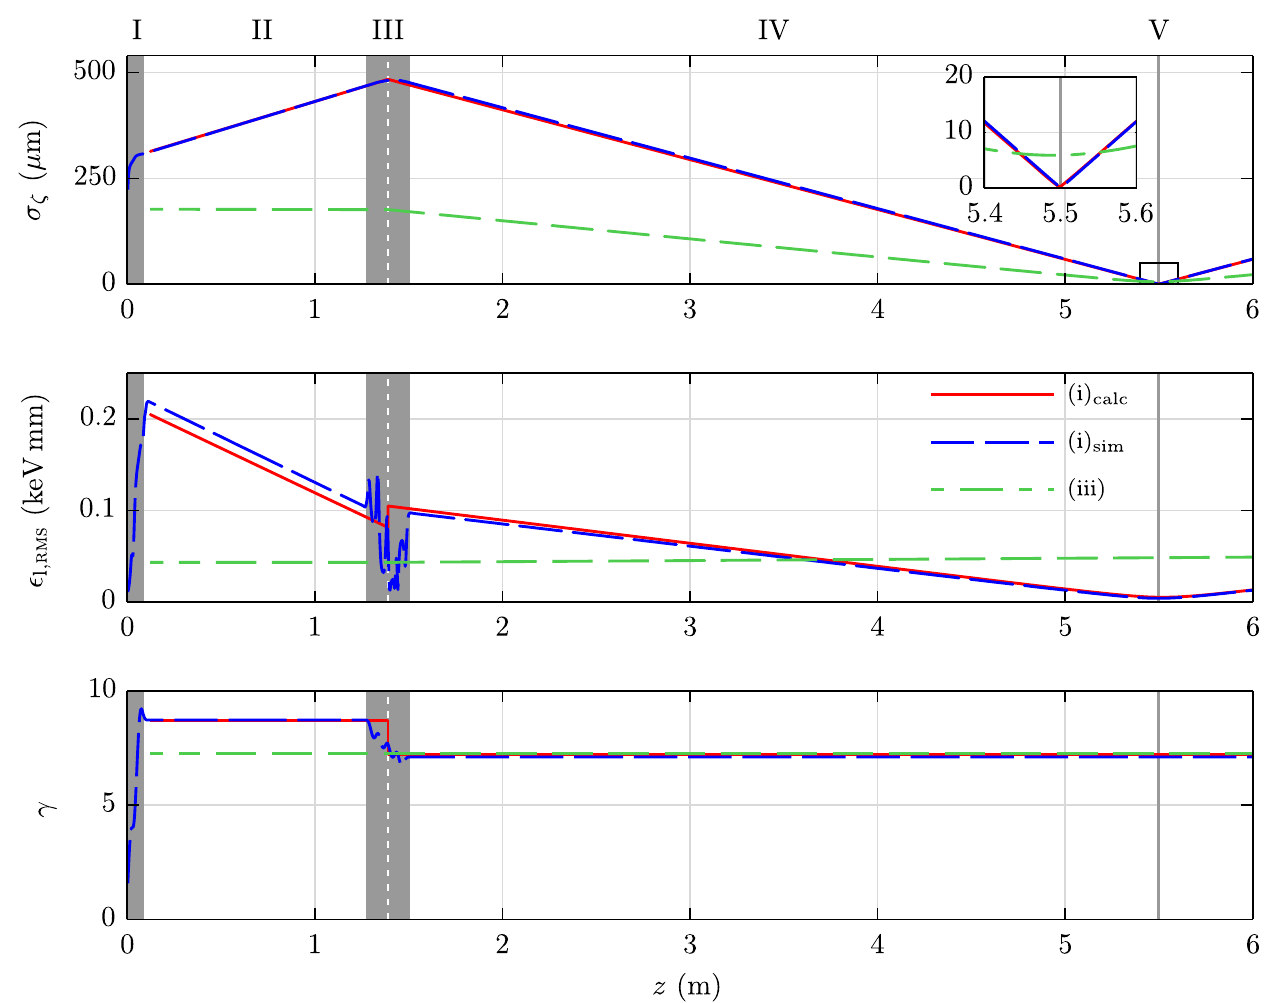
z Þ and the energy γ ð z Þ along the beam line for the FIG. 6. Evolution of the bunch length σ ζ ð z Þ , the longitudinal emittance ϵ 1 ; RMS ð case (i) — analytical calculation and simulation — and case (iii), calculation only. Both versions of (i) are in very good agreement. The bunch length in (i) is first increasing, since the gun is set for an expanding phase, in contrast to (iii), where it does not change. The position of the minimum coincides for all cases, but the bunch is shorter for case (i) in the minimum. The emittance has a local minimum at the same position, indicating the vanishing of the second order of (i), while in (iii) there is almost no change. The bunch energy for case (iii) stays constant as well, while in (i) a deceleration takes place in the